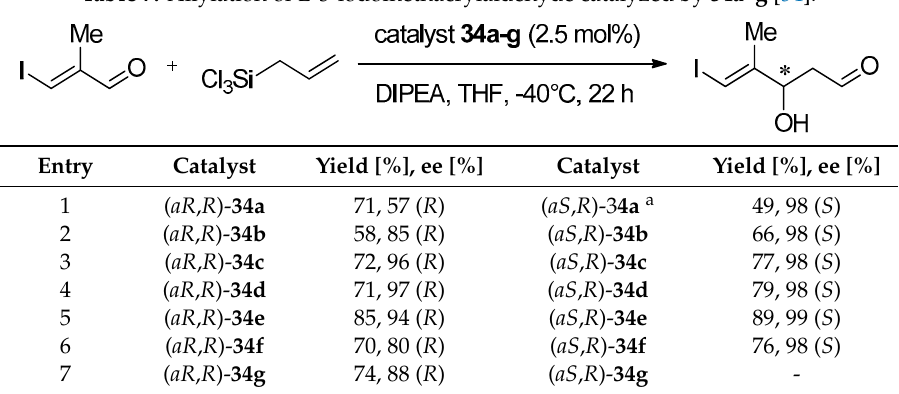
a Reaction time: 45 h.